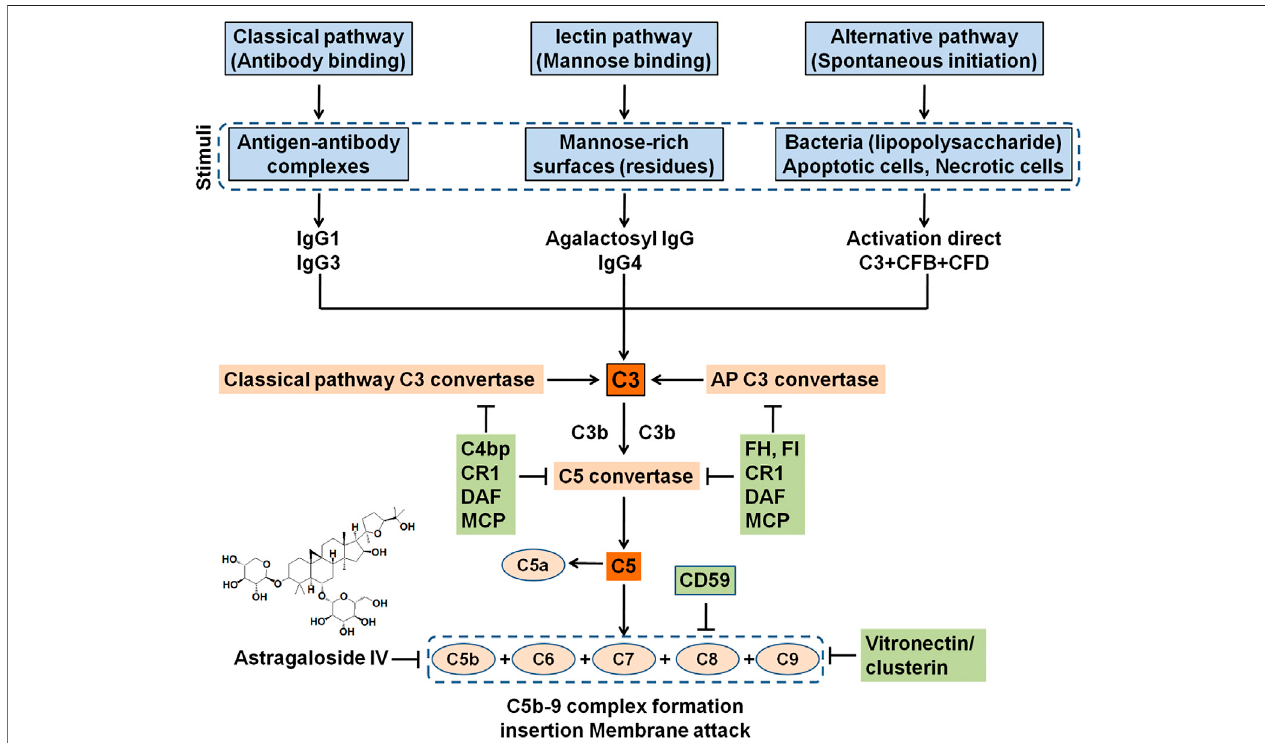
FIGURE 2 | Activation of complement system-induced formation of MAC (C5b-9). Complement could be activated by three pathways including classical, lectin, and alternative signaling pathways, which came together toward production of C5 convertase and formation of C5b that bound to C6, C7, C8, and multiple C9 to generatetheMAC.Thisprocesscouldbemostlyinhibitedbycirculatinginhibitors,podocyte-positiveregulatoryproteins,andnaturalproductssuchasAstragalosideIV. However, this inhibitory effect might be devastated at high levels of complement. MAC could insert into the podocyte membrane, even in sublytic quantity, evoked cell injury under a lack of in fl ammation condition.